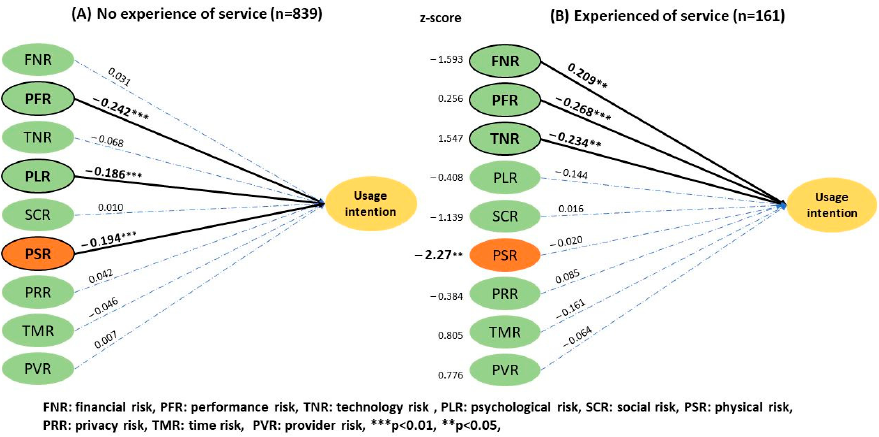
Figure 8. Results of the two-group structural model of experience.